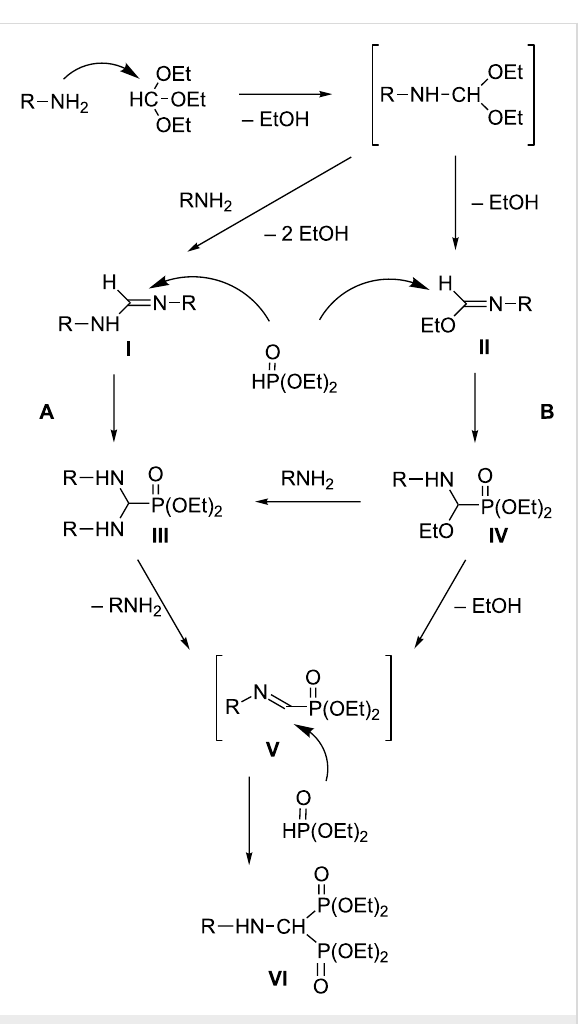
Scheme 1: Proposed routes for the three-component condensation